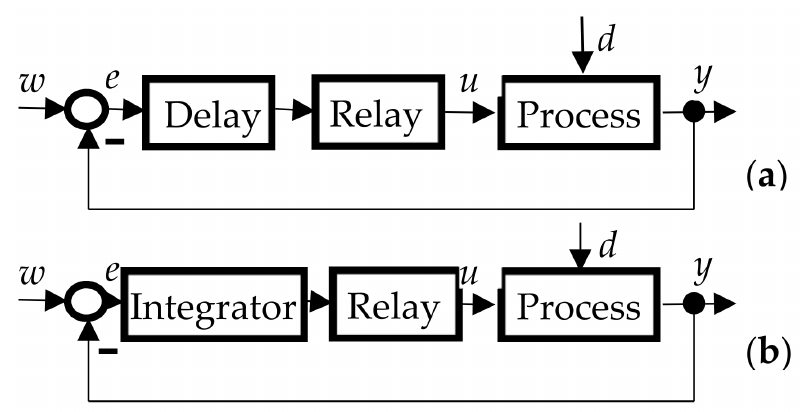
Figure 5. Relay feedback with additional delay ( a ) and with additional integrator ( b